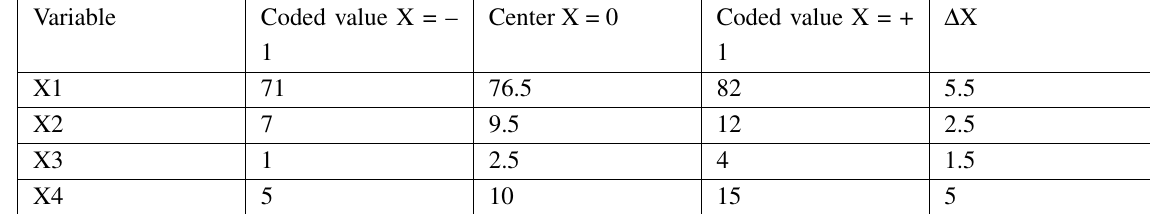
Table 3. Levels of design in 2 4 factorial